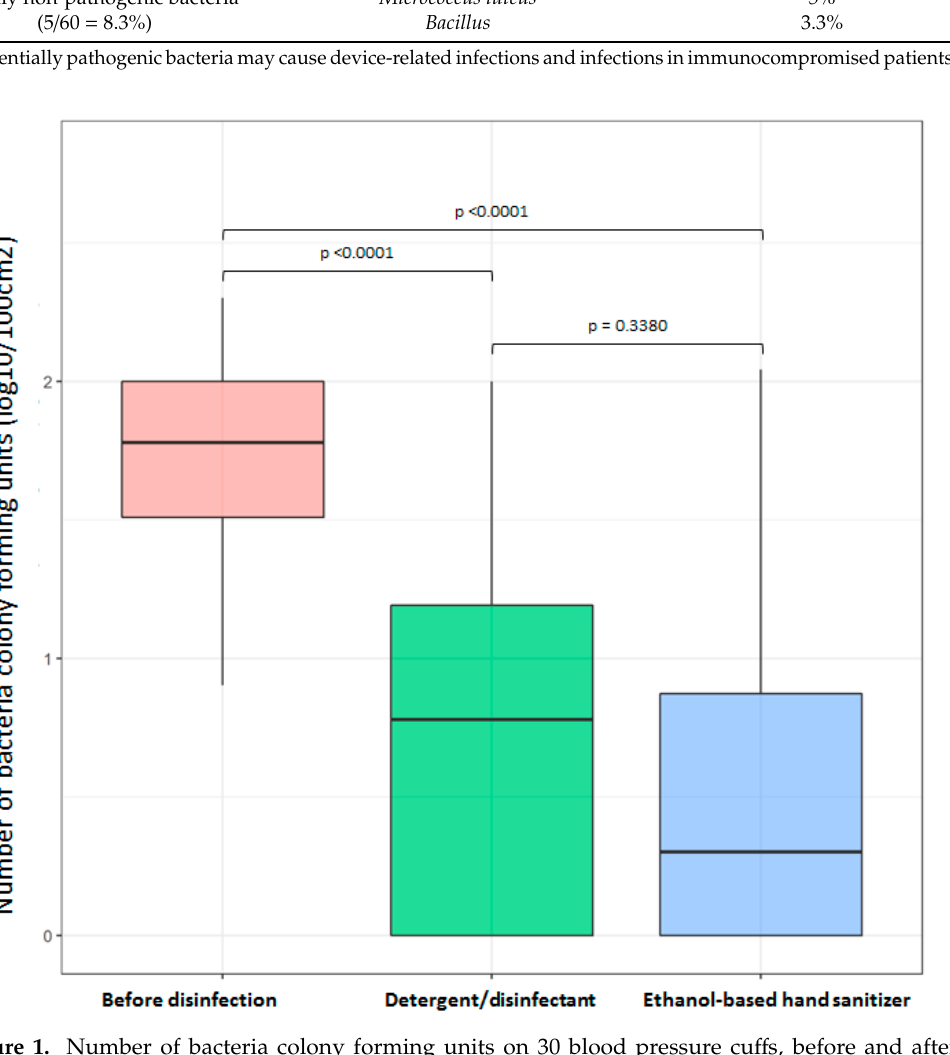
Figure 1. Number of bacteria colony forming units on 30 blood pressure cuffs, before and after disinfection with the detergent/disinfectant or the ethanol-based hand sanitizer.